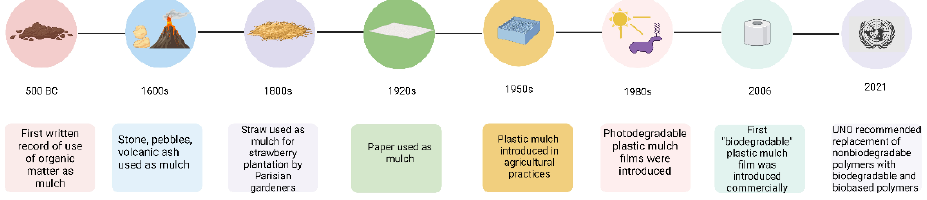
Figure 1. The history and development of different mulching materials.